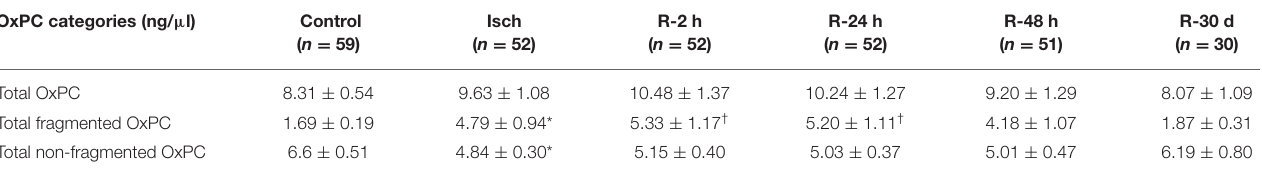
TABLE 3 | Average levels of total OxPCs, fragmented and non-fragmented OxPCs in study groups. OxPC categories (ng/ µ l)